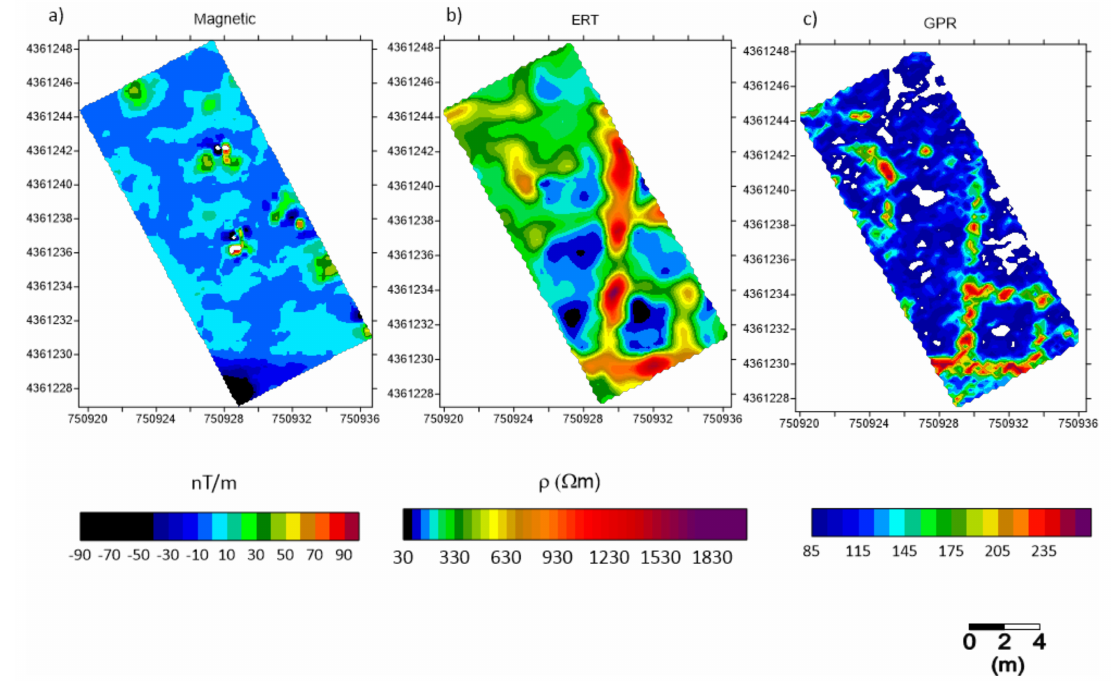
Figure 11. Anomalies from ( a ) the magnetic method, ( b ) ERT and ( c ) GPR at a depth of 0.7 m.